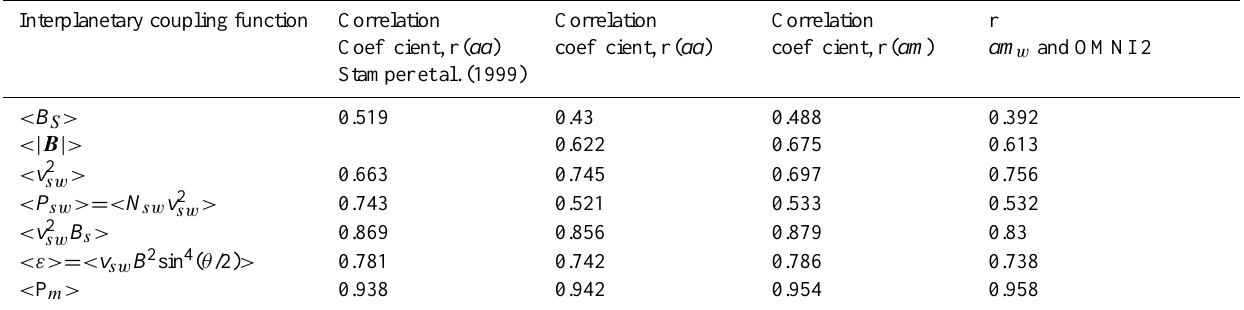
Table 1. Correlations of Annual Means of Interplanetary Coupling Functions with Geophysical Indices aa and am . The interplanetary parameters are: B S , the southward IMF component (in the GSM frame); | B | , the magnitude of the IMF; v sw , the solar wind velocity; P sw , the solar wind dynamic pressure = mN sw v 2 sw , where m is the mean ion mass and N sw is the solar wind plasma density; ε , Akasofu’s epsilon parameter ( ∝ v sw | B | 2 sin 4 (cid:0) θ (cid:14) 2 (cid:1) ), where θ is the IMF clock angle in the GSM frame; and P α , Vasyliunas’ parameter described in Sect. 3. Interplanetary coupling